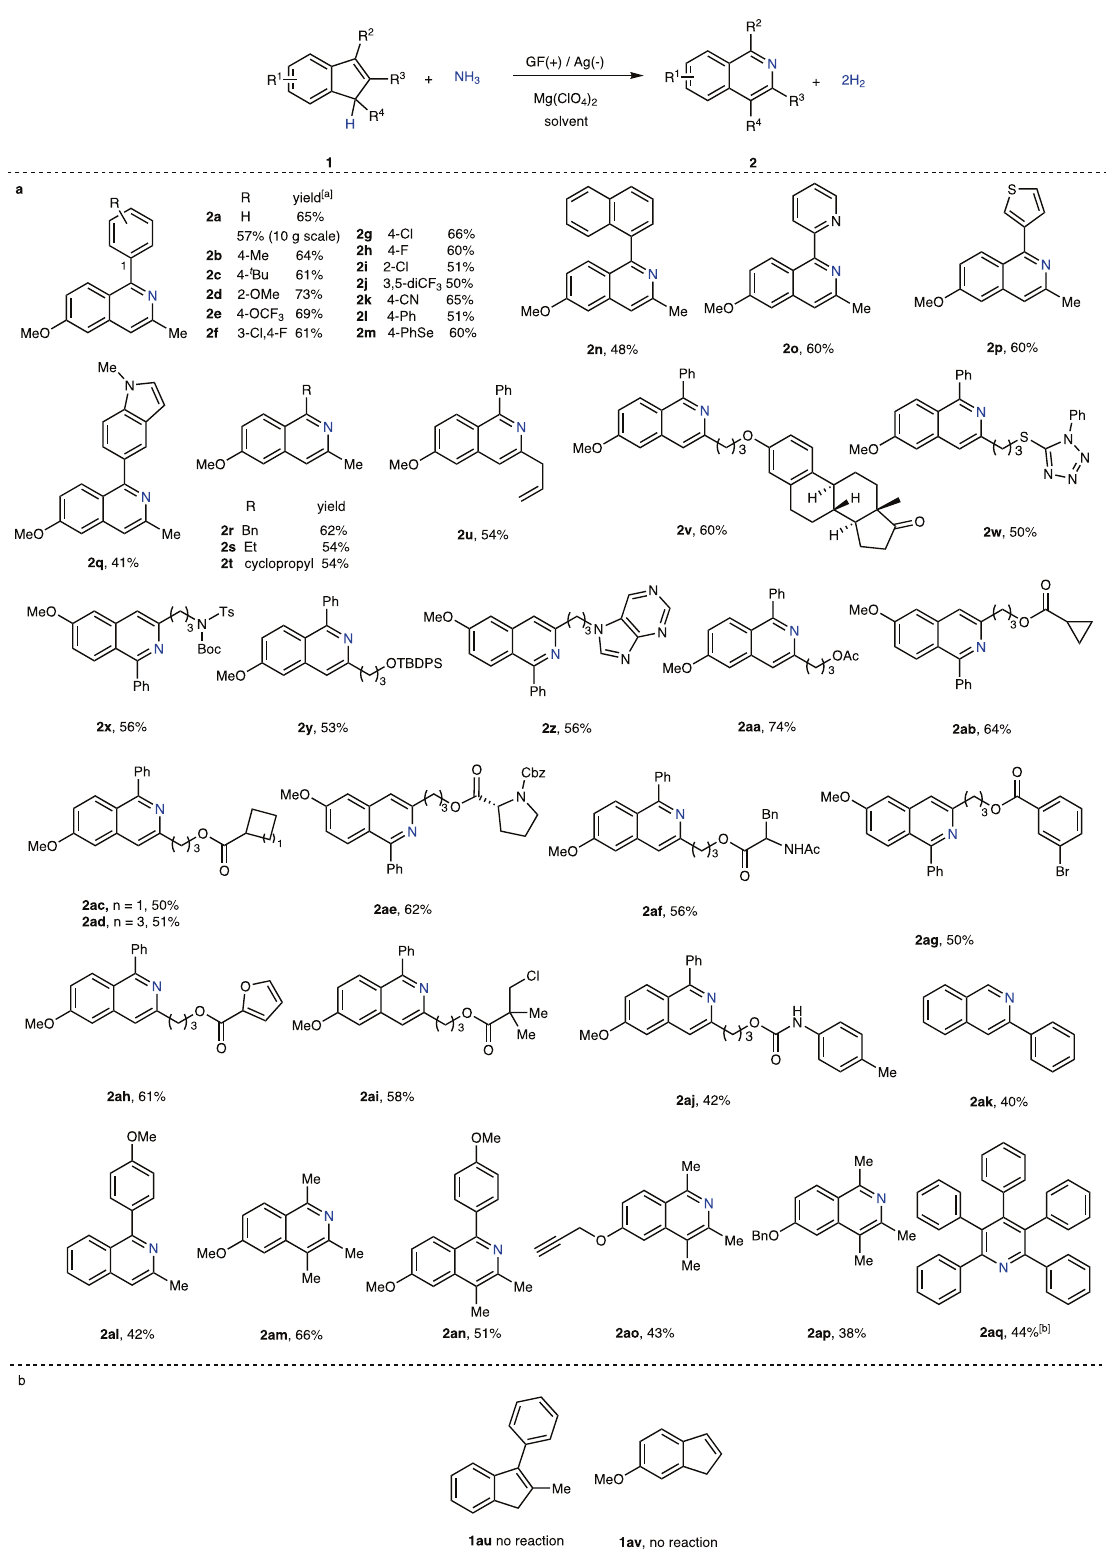
Fig. 2 The insertion of ammonia into various alkenes. a Reaction conditions: graphite felt (GF) anode and Ag cathode, 1 (0.1 mmol), NH 3 (balloon, ca. 1 atm), Mg(ClO 4 ) 2 (0.1 mmol), MeOH/DCM = 4 mL/1 mL, or 3 mL/2mL, 3.5 – 4.5 V cell potential, rt, 3 – 4 h. [a] isolated yields are reported for all cases. = 3 mL/2 mL, 5.5 V cell potential, rt, 3 h. [b] reaction conditions: GF anode and Ag cathode, 1aq (0.05 mmol), Mg(ClO 4 ) 2 (0.1 mmol), MeOH/toluene b Substrates did not react.